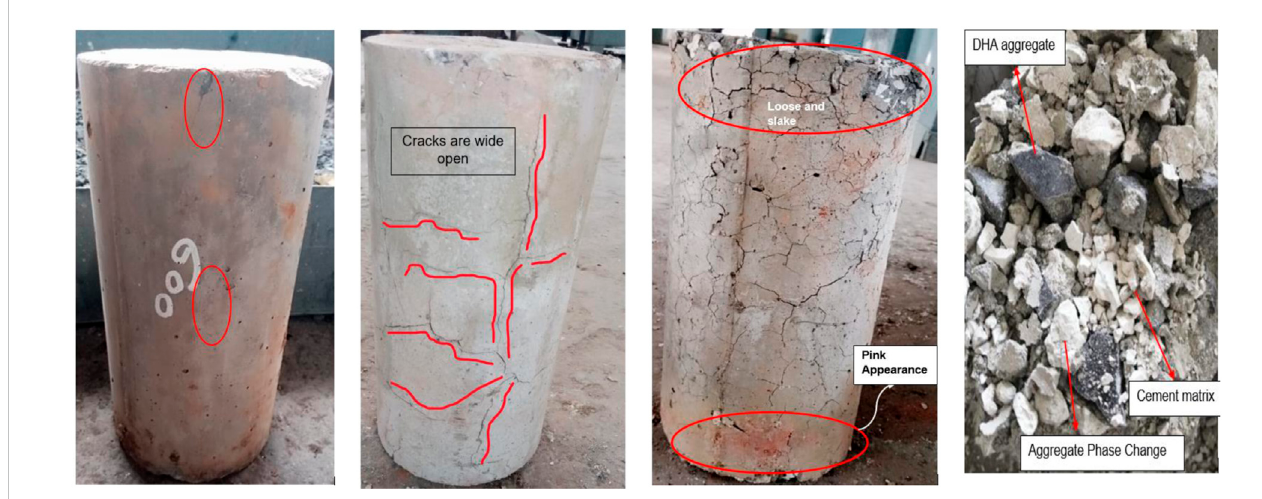
FIGURE 5 DC 3 mixes exposed to temperatures from 600 ° C to 1200 ° C.